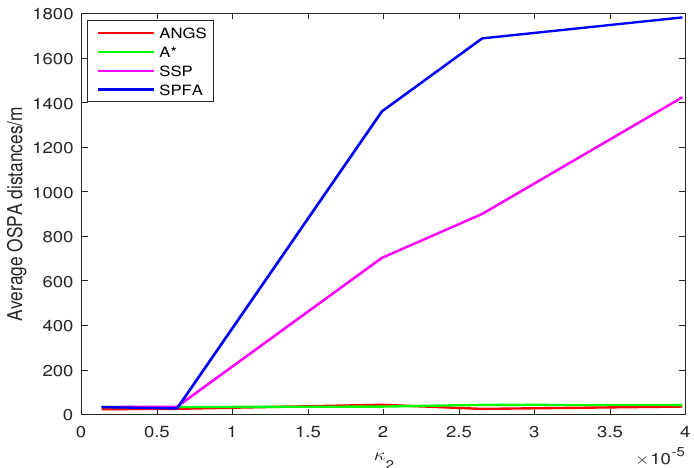
Figure 7. The average OSPA distances versus the Type II clutter intensity in scenario